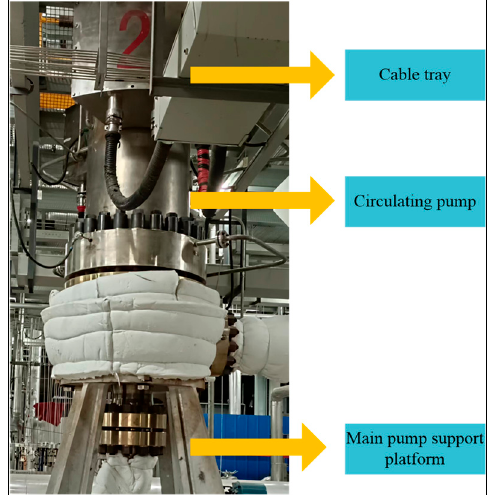
Table 1. Sample number and type of main pump states Figure 10. Main circulation pump.